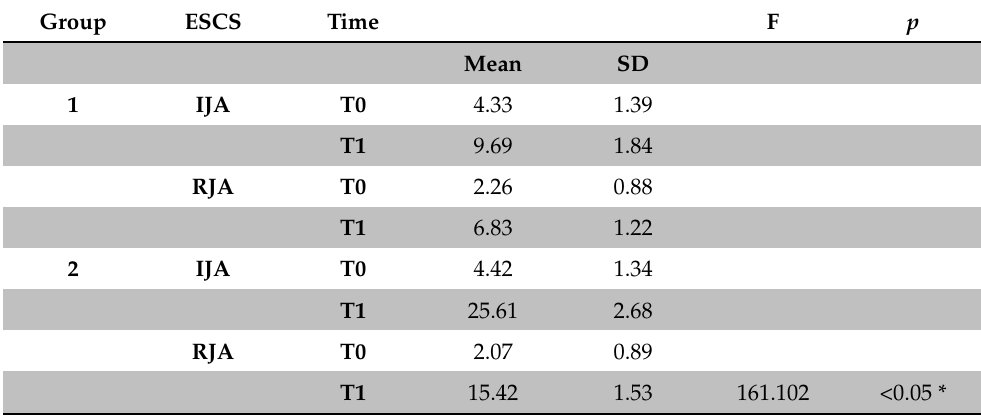
Table 3. Effect of the scale * time * group interaction on the ESCS